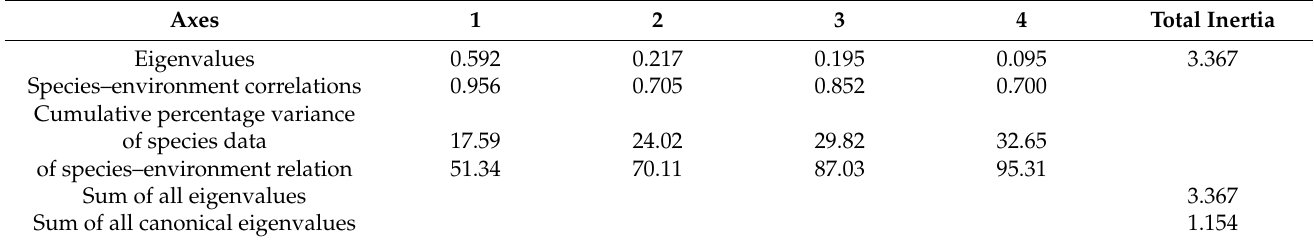
Table 2. Results of canonical correspondence analysis relating fish biomass data to environmental factors adjacent to the Yangtze Estuary,